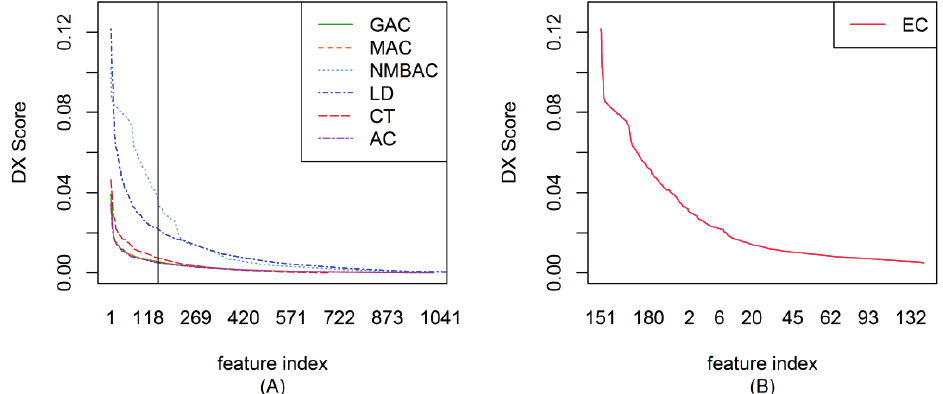
Figure 1. DX score distribution of the different coding methods on the Gold Yeast dataset.